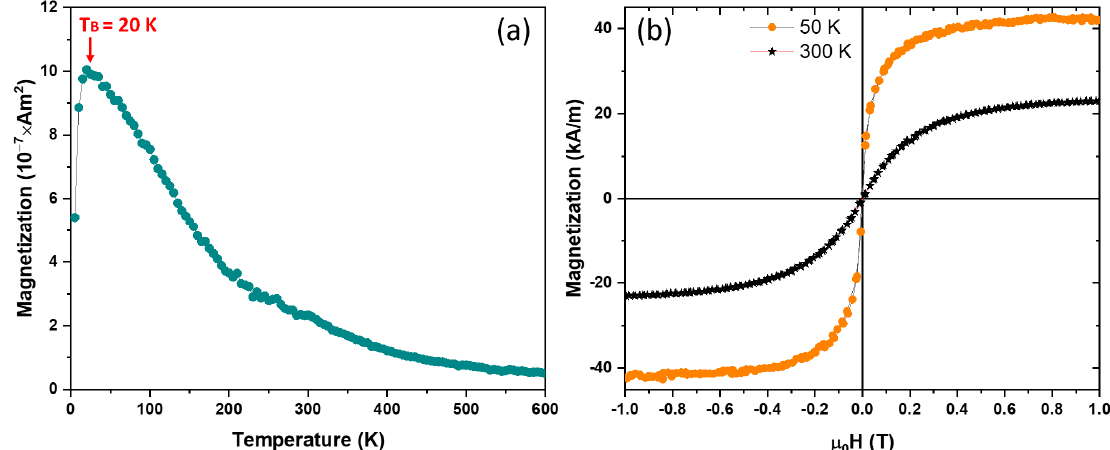
Figure 4. Magnetic properties of the as-made NPs: ( a ) Magnetization (M) vs. temperature (T) data of the as-made NPs; and ( b ) hysteresis loops of the as-made NPs at 300 and 50 K.